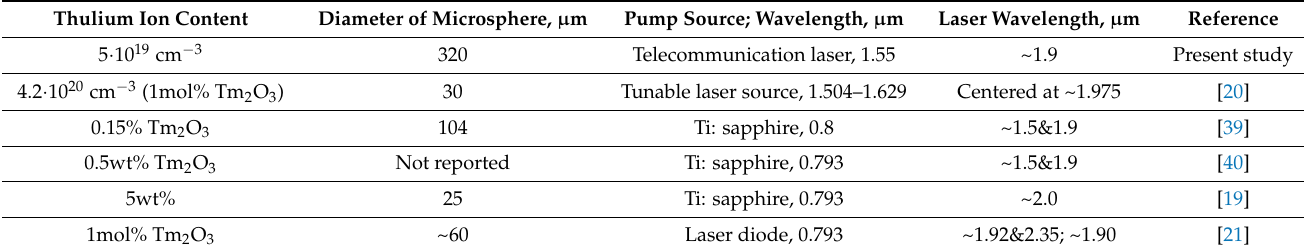
Table 1. Performance of Tm 3+ -doped tellurite glass microsphere